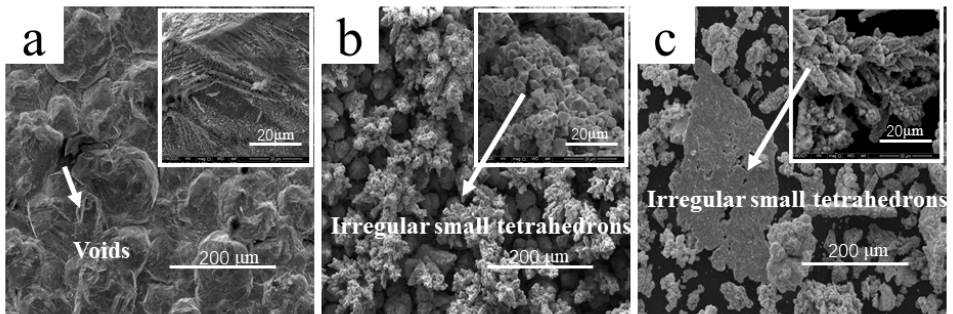
Figure 10. The microscopic morphology of the cathode copper with different Cd 2+ concentrations in the third stage of the cyclone electrowinning process: ( a ) 0 g/L, ( b ) 2 g/L, ( c ) 3 g/L.